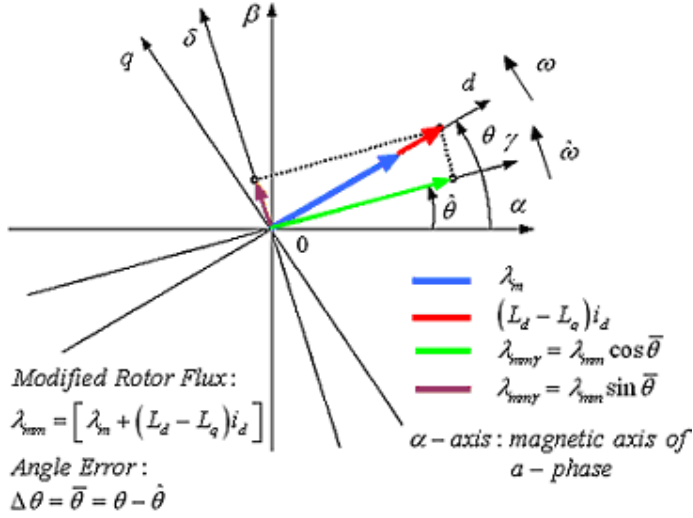
Figure 2. Vector diagram of the modified rotor flux λ mm in dq and γδ (rotating) reference frames as they related to αβ (stationary) reference frame with α representing magnetic axis of phase a.